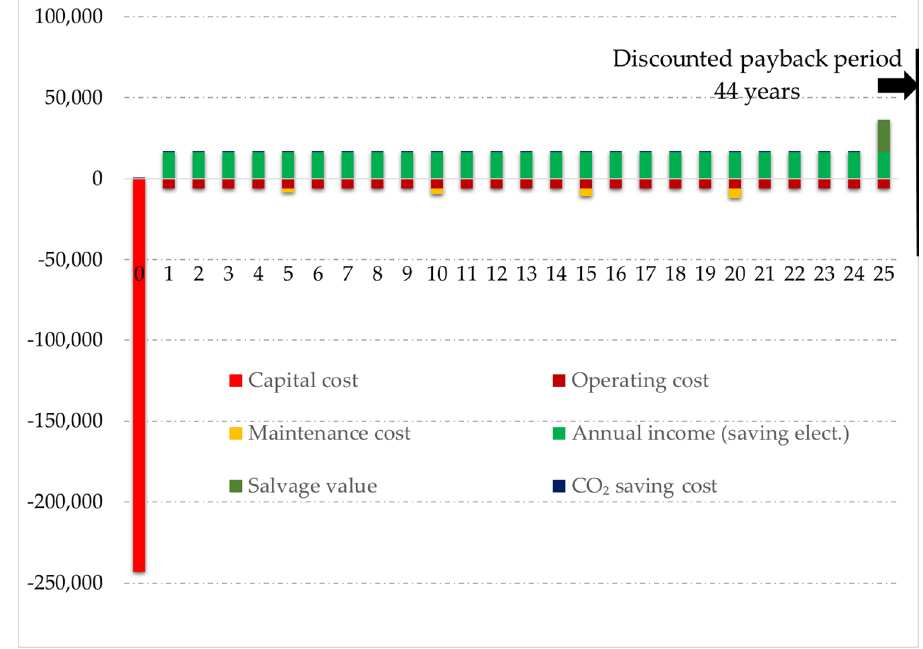
Figure 11. Absorption cooling system cash flow diagram with an average observed COP of the absorption chiller of 0.32.